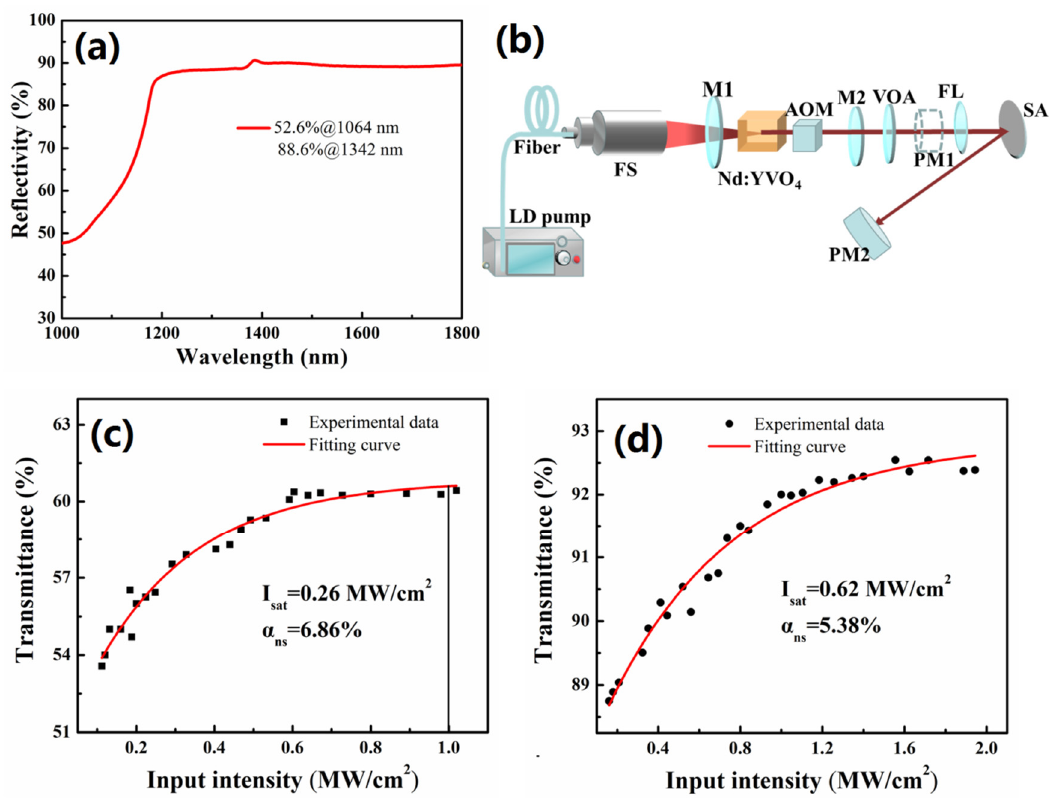
Figure 2. ( a ) Reflectivity spectrum, ( b ) schematic diagram of the experiment setup of nonlinear transmission measurement, nonlinear transmission of Mo 2 C SAs at ( c ) 1064 nm and ( d ) 1342 nm central wavelength.